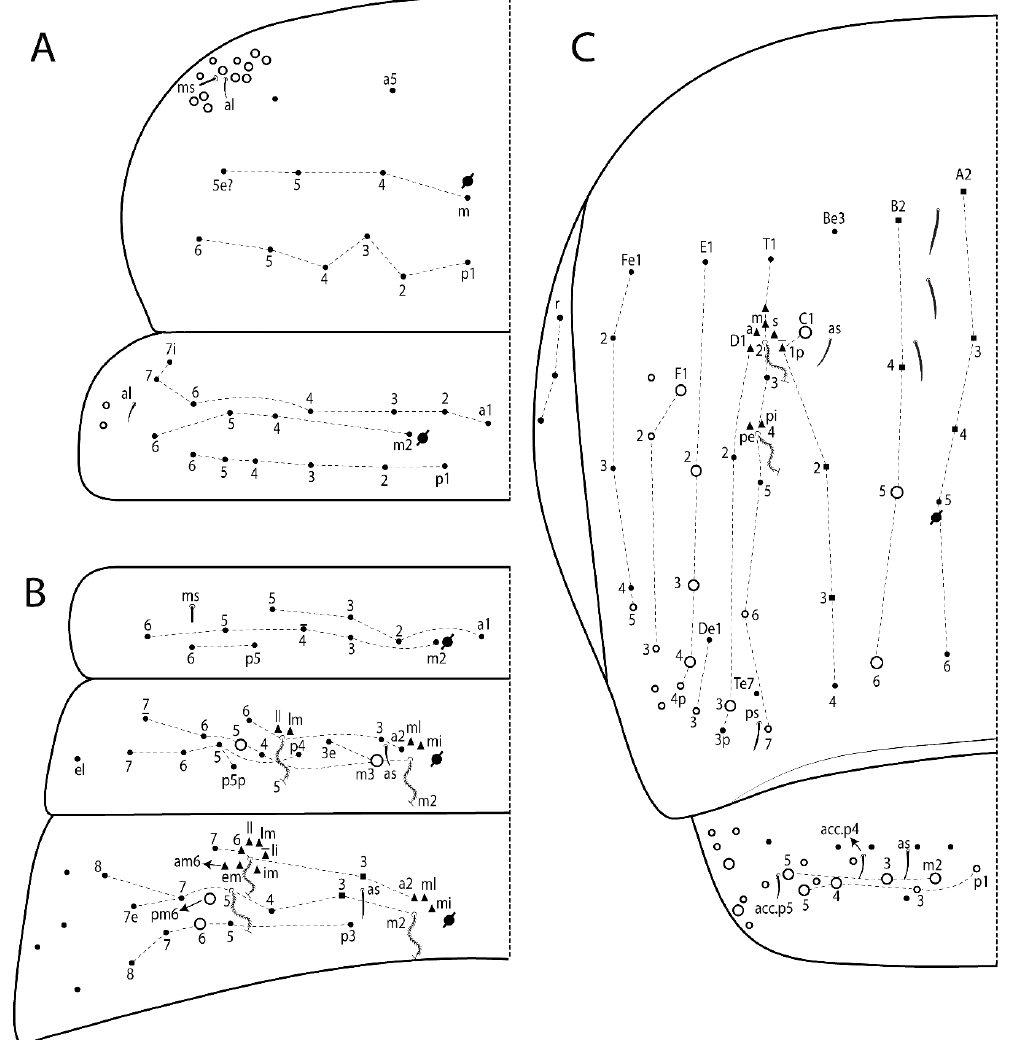
Figure 62. Pseudosinella spurimarianensis sp. nov.: dorsal chaetotaxy. ( A ) Th II–III; ( B ) Abd I–III; ( C ) Abd IV–V.